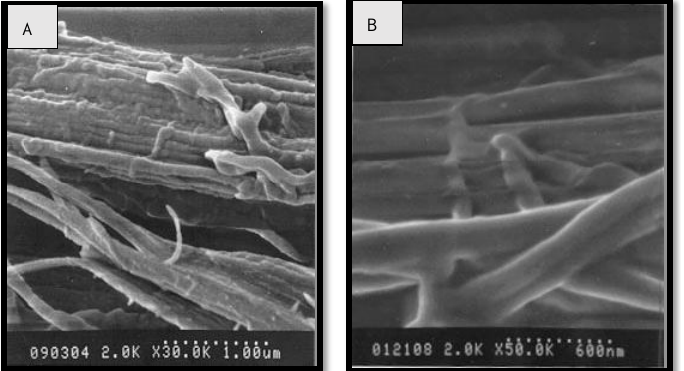
Figure 9. SEM images of peeled silks; ( A ) A. pernyi and ( B ) A. yamamai . Reprinted/adapted with permission from Ref. [64]. Table 4. Properties of mulberry and Nephila dragline silk [66,69 – 74].